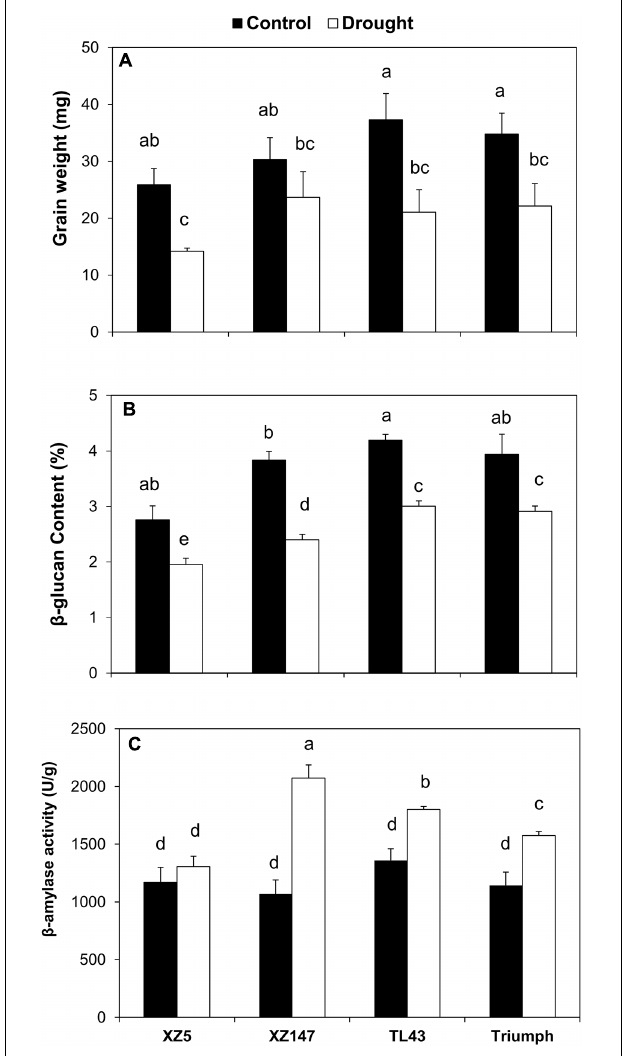
FIGURE 1 | The effect of water stress on grain weight (A) , β -amylase activity (B) , and β -glucan content (C) of different barley genotypes. Different letters indicate the significant difference between each genotype × treatment combination at 95% probability. Data are mean ±